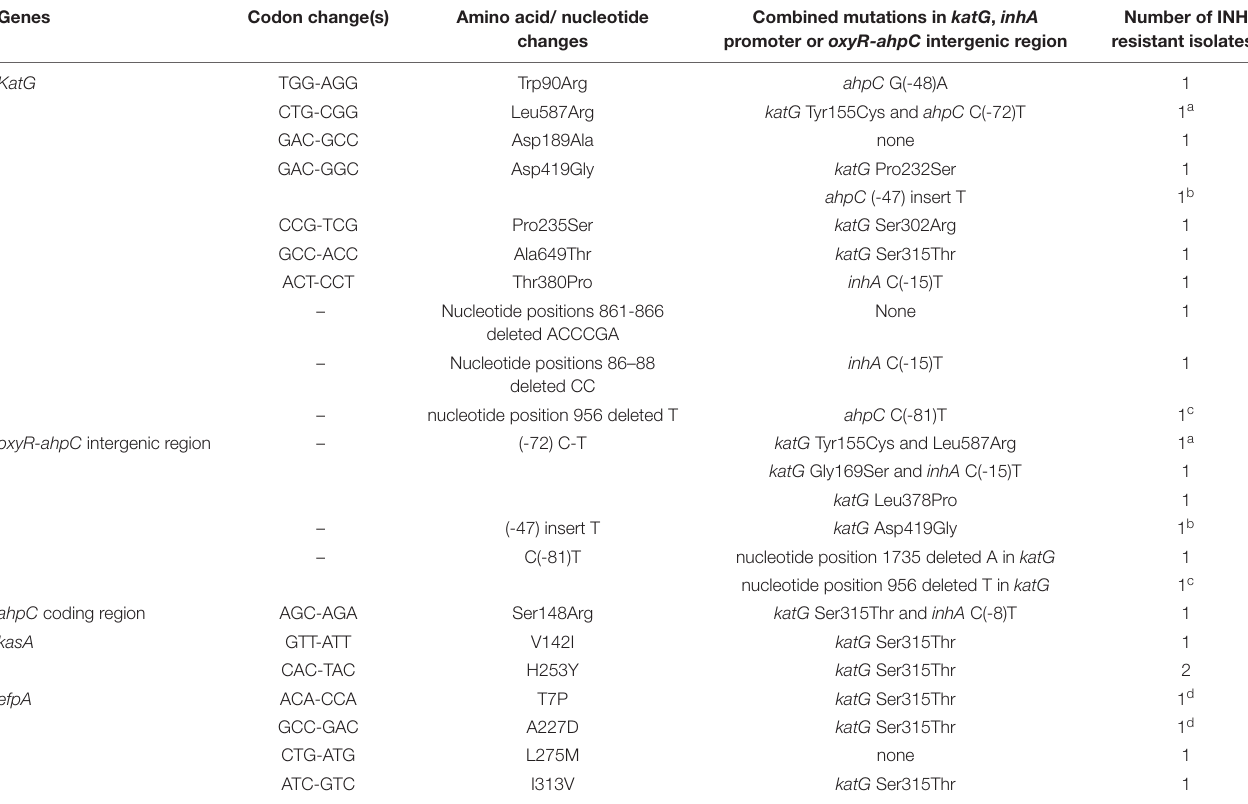
TABLE 4 | Novel mutations occurred in genes and regions associated with isoniazid resistance and found only in phenotypic isoniazid resistant M. tuberculosis .